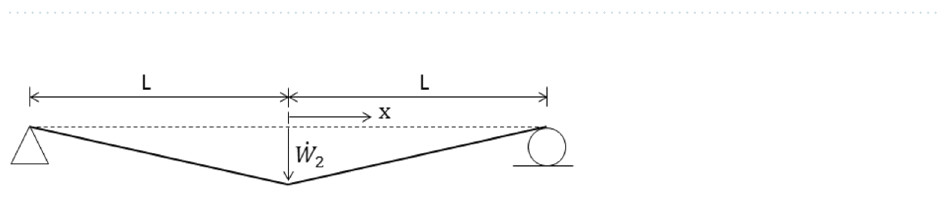
Figure 7. Sketch showing the distribution of transverse velocity during Phase 2 of the